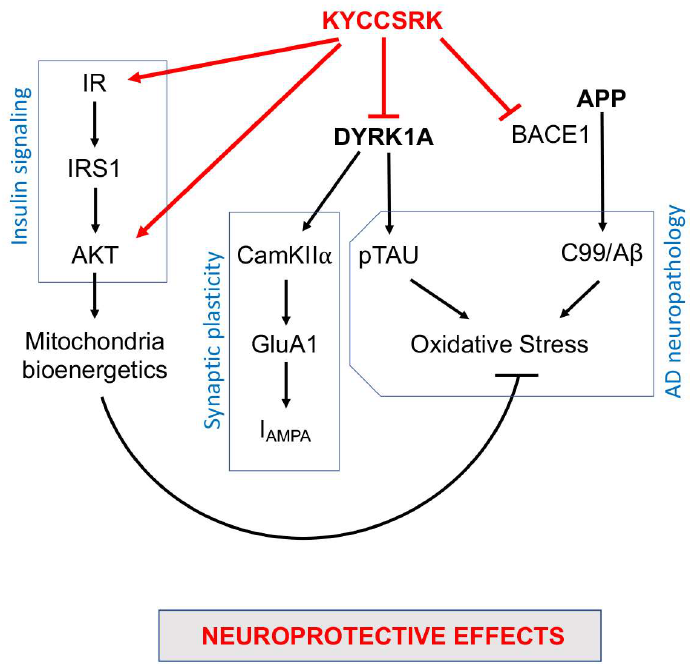
Figure 8. Schematic representation of the molecular mechanisms associated with the neuroprotective effects mediated by the intranasal administration of the KYCCSRK peptide in Ts-P mice. Arrows: stimulation; lines: inhibition.